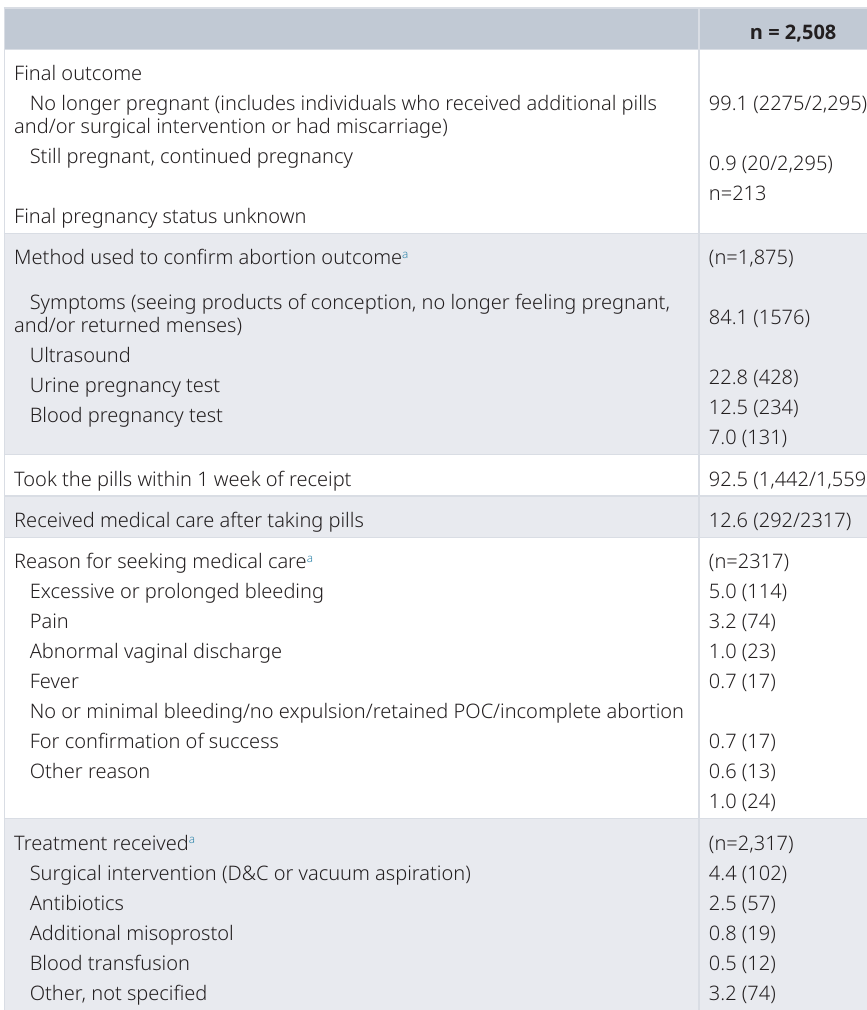
Table 2. Self-reporting of outcomes among individuals who confirmed having used abortion pills from WHW % (n). Final